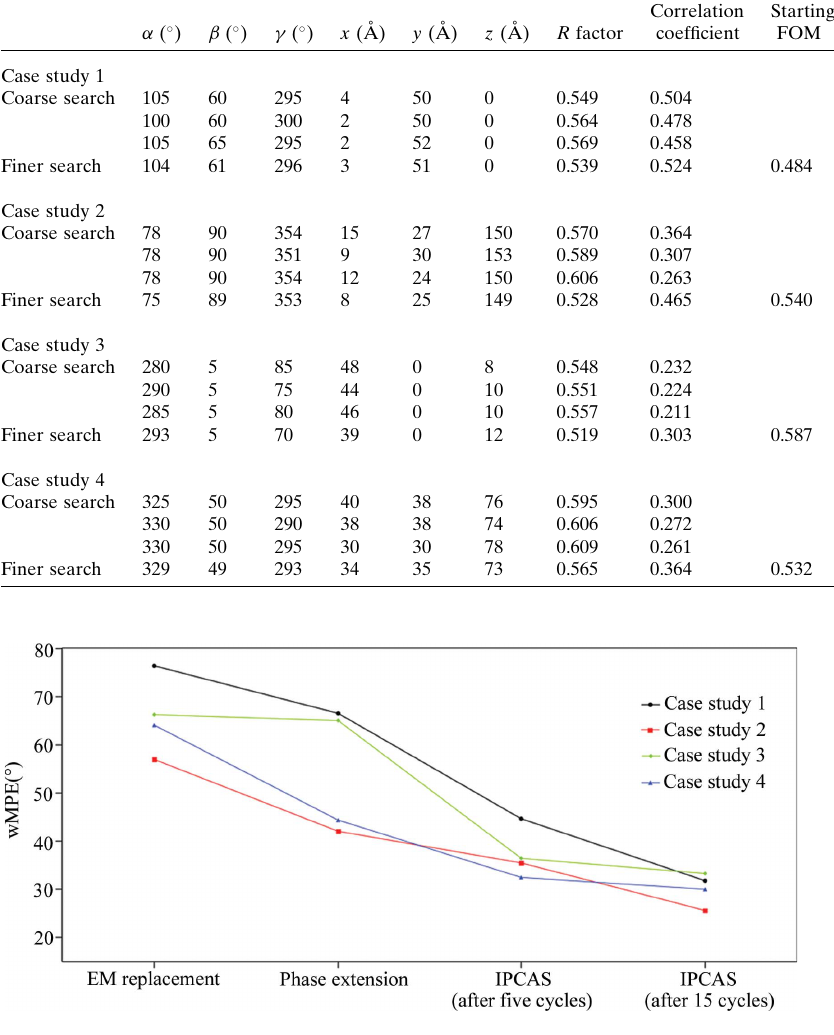
Figure 2 Plot of figure-of-merit-weighted mean phase error (FOM-wMPE) calculated against the crystal structure at the key steps of the whole